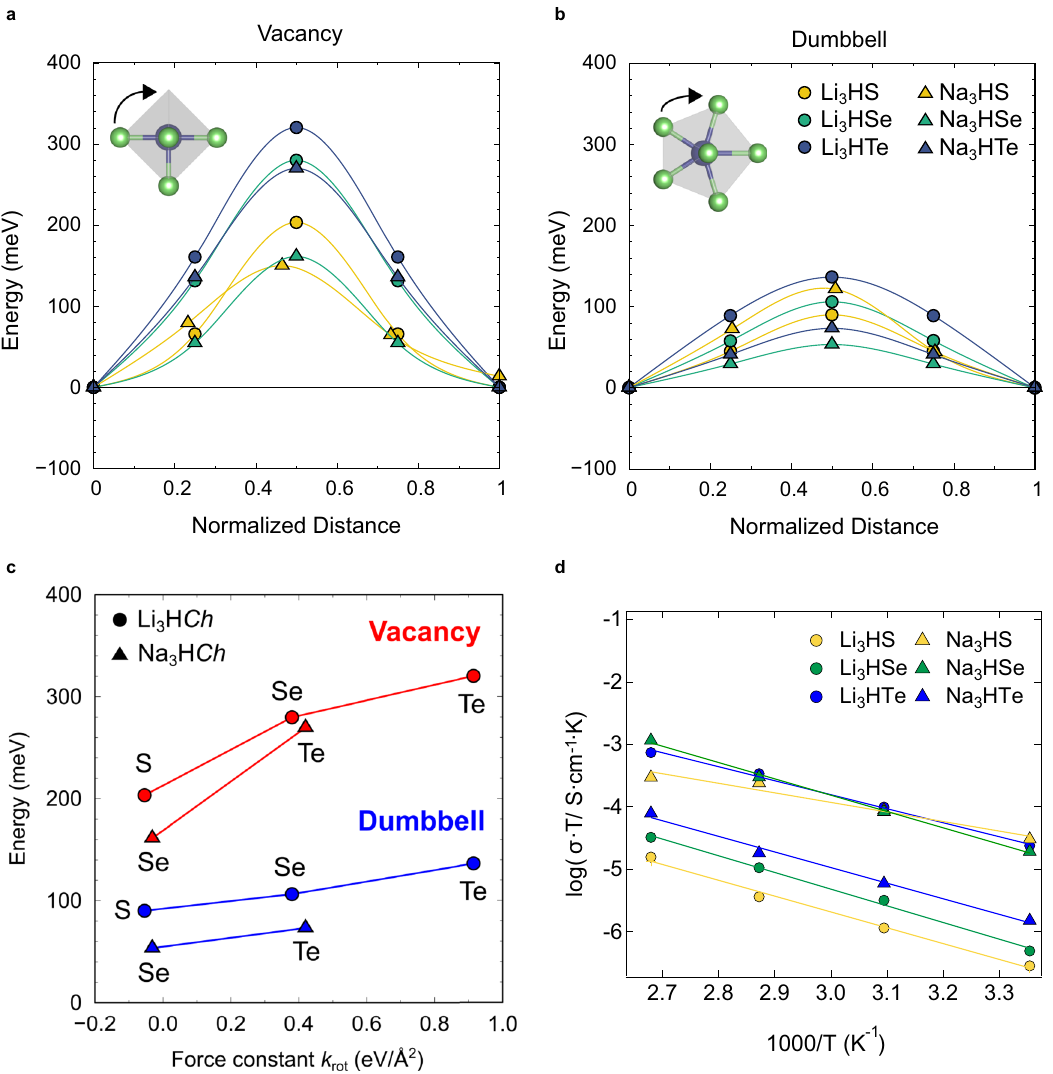
Fig. 5 Ionic conductivities of M 3 HCh antiperovskites (M = Li, Na, and Ch = S, Se, Te). Low-barrier migration pathways for a vacancy and b interstitial dumbbell migration in M 3 HCh. Top-left insets show M + migration when viewing HM 6 octahedron from the top to down. For orthorhombic Na 3 HS, there are many migration pathways, one of which is shown as a representative example (see Supplementary Fig. 15 for details). c Migration barriers for cation transport via the vacancy and interstitial dumbbell mechanism in M 3 HCh as a function of the force constant k rot with respect to the HM 6 rotational motion. d Arrhenius plots of the total conductivity values for undoped M 3 HCh cold-pressed samples in the temperature range from 25 to 100